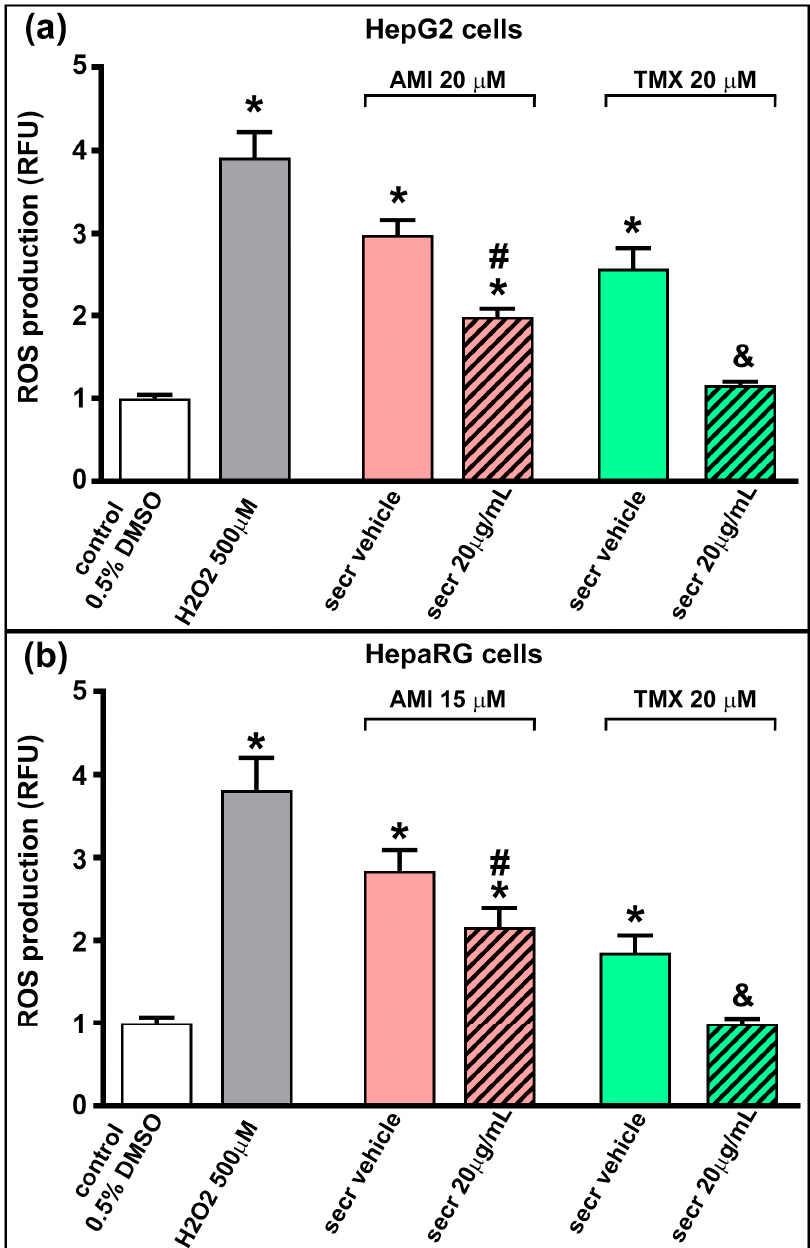
Figure 5. MSC secretome decreased intracellular ROS production in hepatic cells incubated with AMI or TMX. The production of reactive oxygen species (ROS) was evaluated in ( a ) HepG2 and ( b ) HepaRG cells exposed to AMI (red bars) or TMX (green bars) alone or coincubated with MSC secretome (20 µ g/mL—line pattern bars) for 15 h. As control group, cells were incubated with the drug vehicle alone (0.5% DMSO—white bars), whereas peroxide hydrogen (H 2 O 2 ) was used as positive control (gray bars). Intracellular ROS staining was performed with H2DCFDA (10 µ M), and the fluorescence intensity was quantified and expressed as fold of change vs. control group (0.5% DMSO). The exposure to AMI and TMX induced ROS production in both cell lines (evidenced by the increased fluorescence), whereas the coincubation with MSC secretome reduced the ROS production. Data are presented as mean ± SEM ( n = 6) of three independent experiments. * p < 0.05 vs. control group (0.5% DMSO); # p < 0.05 vs. AMI plus secretome vehicle (PBS) of the same experimental group; & p < 0.05 vs. TMX plus secretome vehicle (PBS) of the same experimental group. RFU: relative fluorescence units; secr vehicle: (secretome vehicle, PBS); secr: (MSC